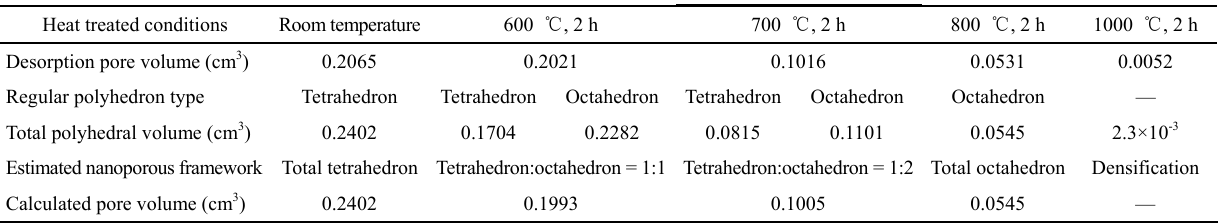
Table 3 Estimated porous framework and calculated pore volume of SiO 2 aerogels treated at different